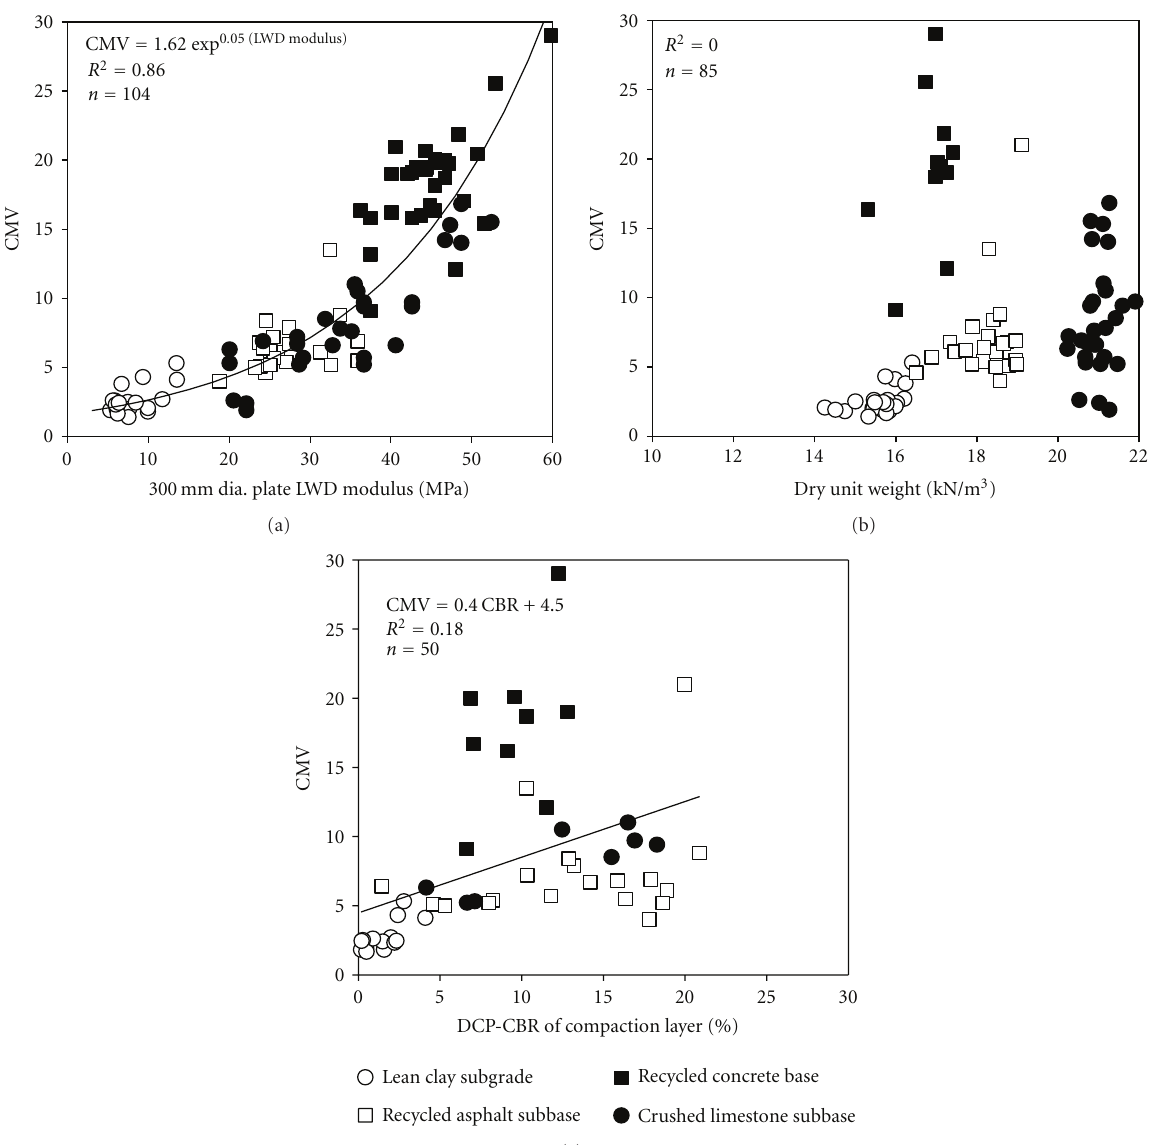
Figure 3: Relationships between CMV (theoretical amplitude = 1.50 mm) and in situ point measurements (LWD modulus, dry unit weight, and CBR determined from